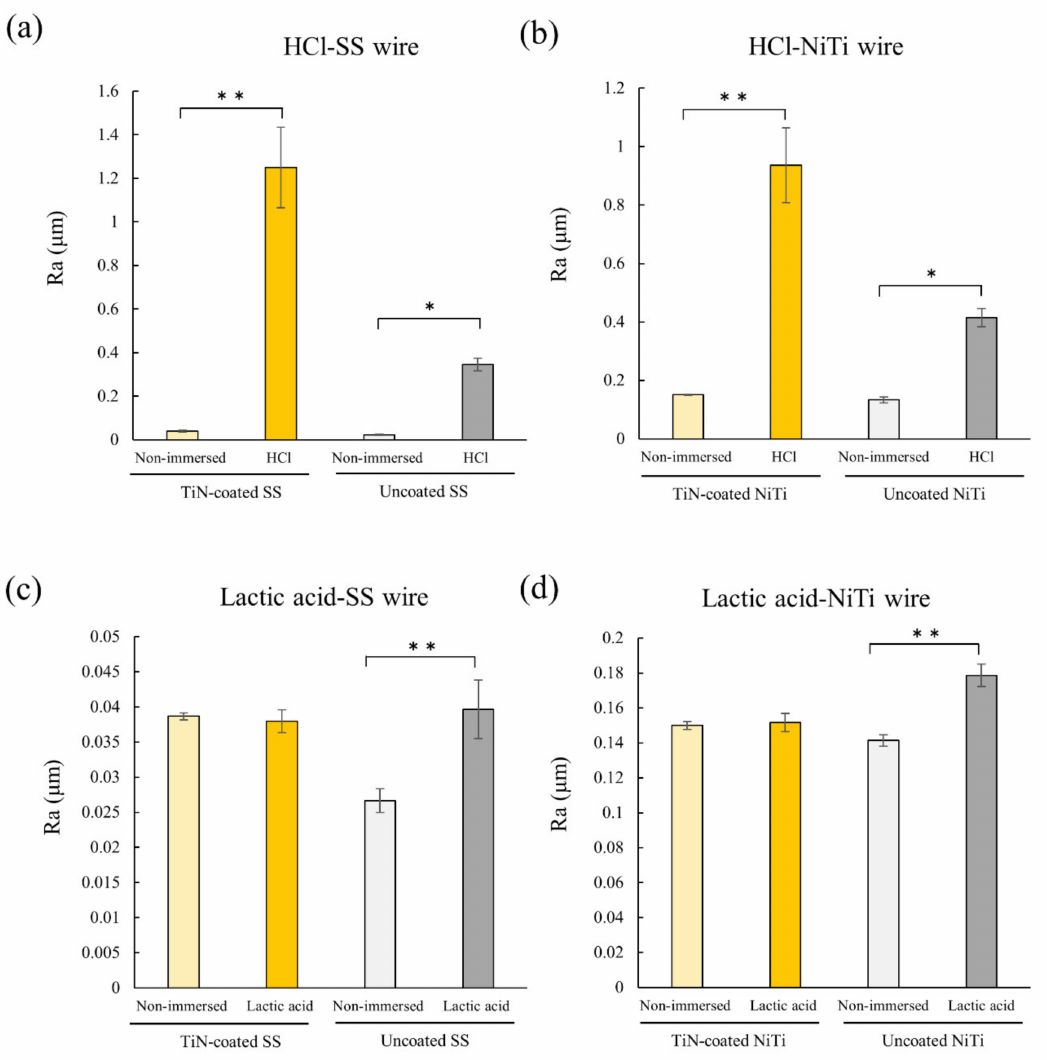
Figure 5. Comparison of surface roughness of orthodontic arch wires after immersion in HCl or lactic acid. After immersion in HCl or lactic acid for 30 min, the surface roughness (Ra) of orthodontic arch wires was assessed using a surface roughness tester: ( a ) SS wire immersed in HCl; ( b ) NiTi wire immersed in HCl; ( c ) SS wire immersed in lactic acid; ( d ) NiTi immersed in lactic acid. The statistical of differences was determined by the Tukey-Kramer HSD test. (* p < 0.05, ** p <